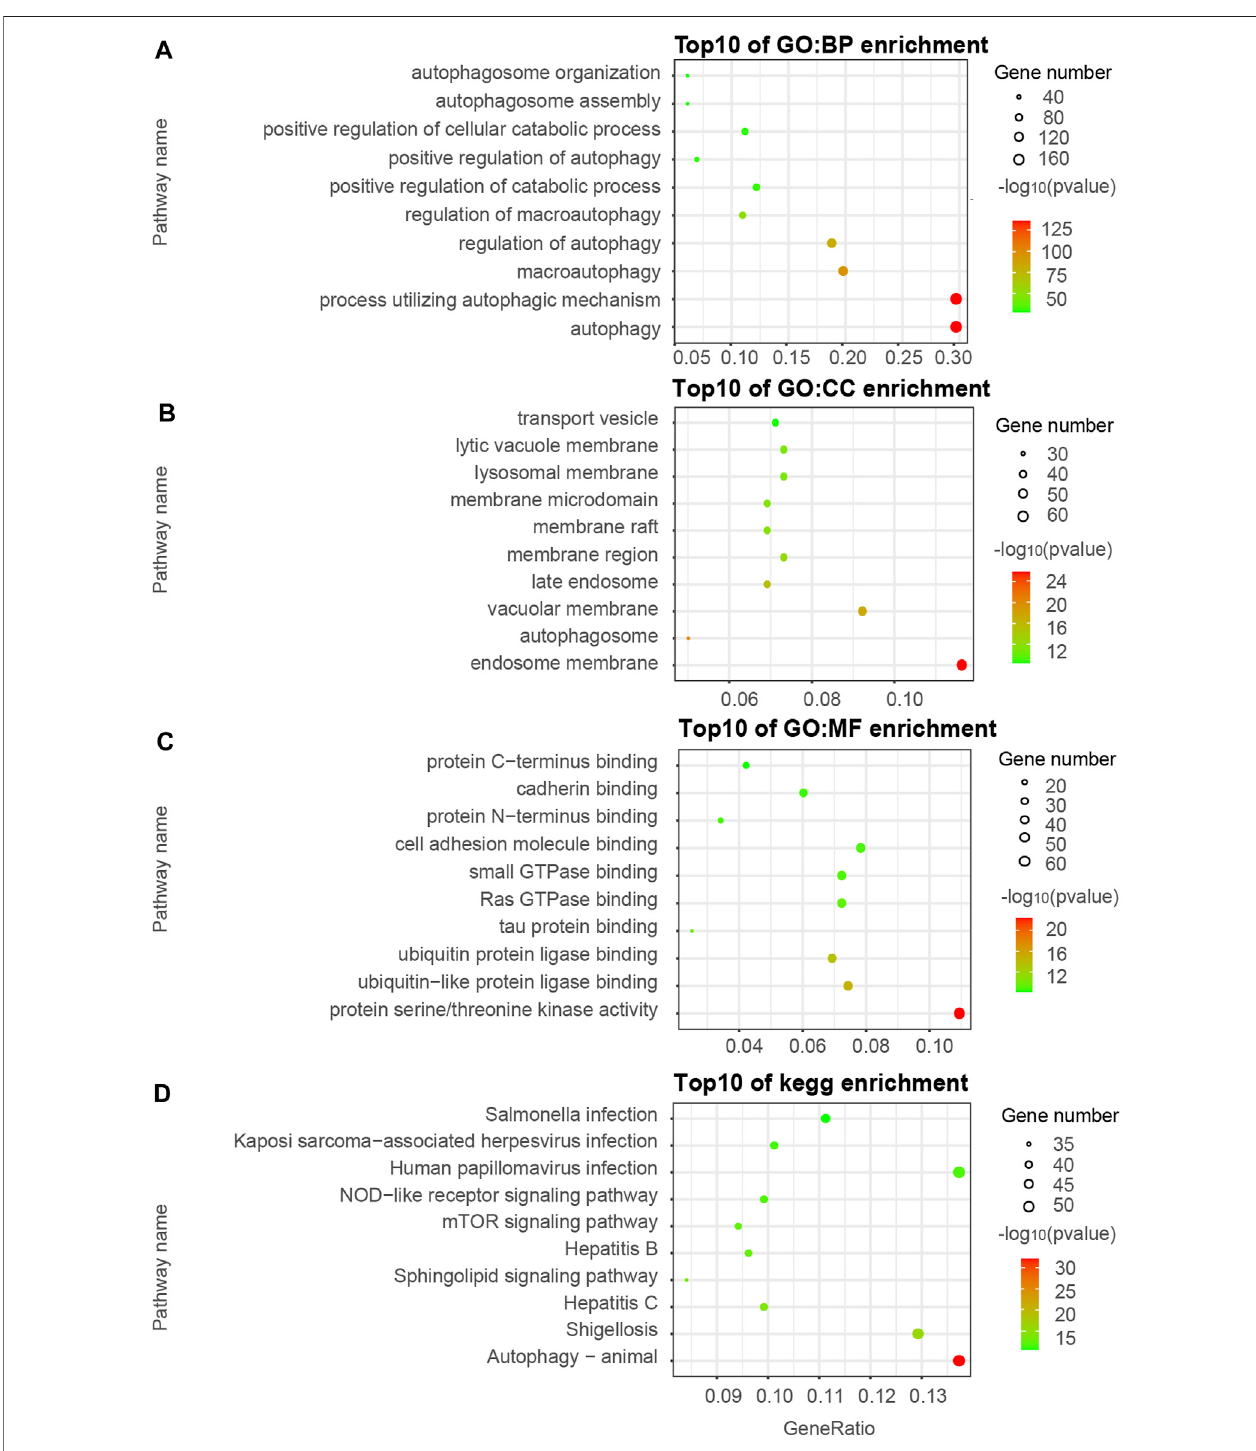
FIGURE 3 | Gene ontology (GO) and KEGG pathway enrichment analyses of ATGs in Turquoise (A – D) modules.